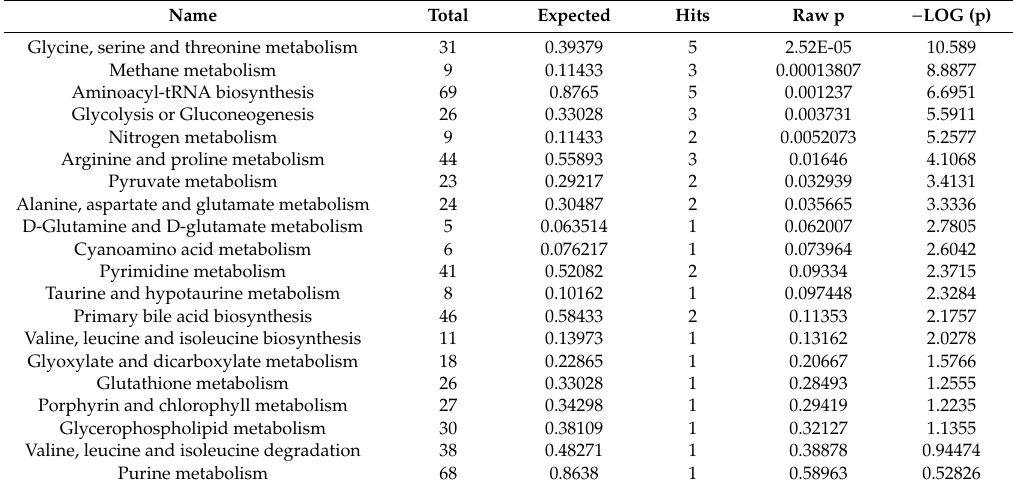
Table 3. Pathway analysis associated with the di ff erential LPS metabolites.